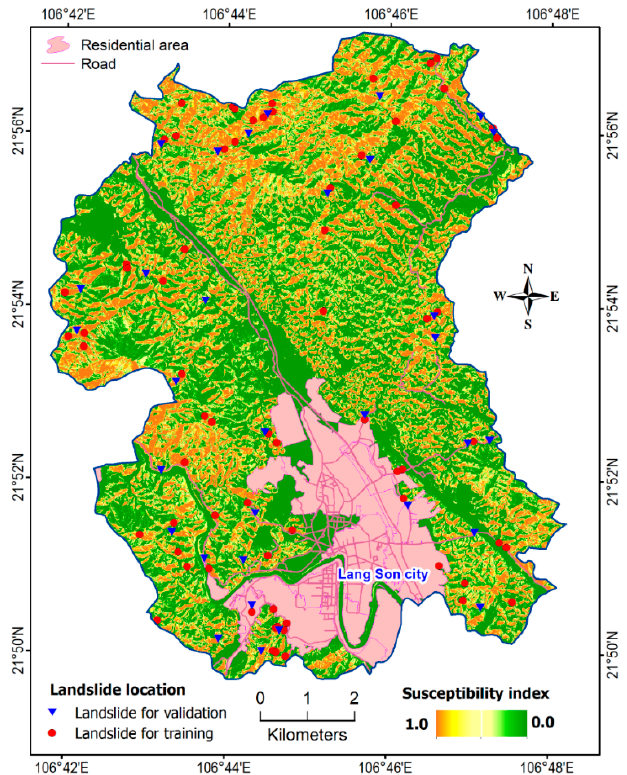
Figure 10. The landslide susceptibility map for the study area derived from the proposed random forest machine model.